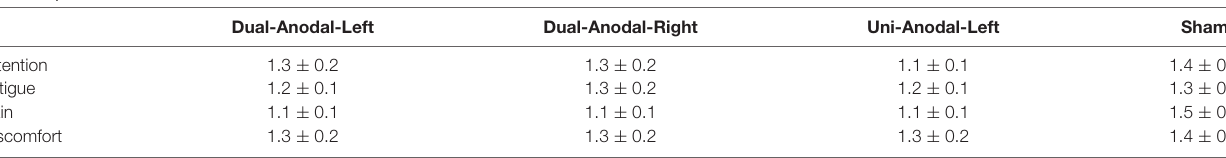
TABLE 1 | Questionnaire scores after each intervention. Dual-Anodal-Left Dual-Anodal-Right Uni-Anodal-Left Sham Attention 1.3 ± 0.2 1.3 ±